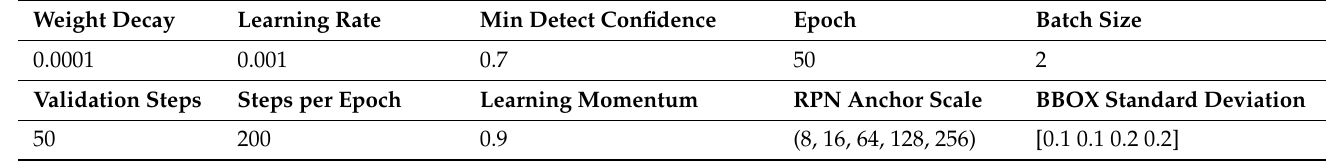
Table 2. Parameter configuration for this experiment.